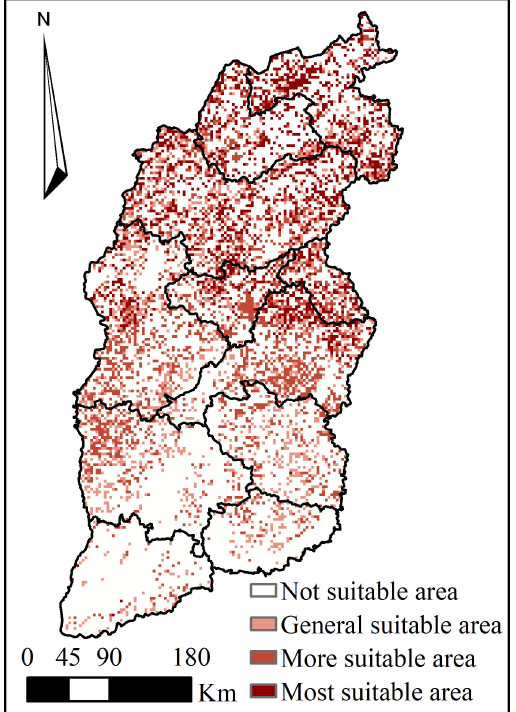
Figure 9. Suitable area of solar energy resource in Shanxi